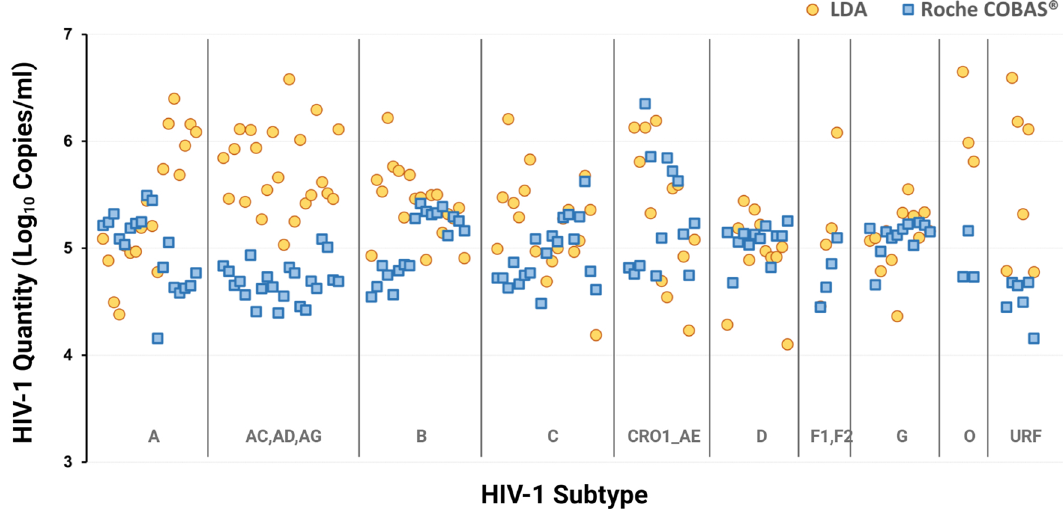
Figure 3. Comparison of HIV-1 viral load measurements by HIV-1 subtype determined by the revised laboratory developed assay (LDA) and the Roche Cobas AmpliPrep/Cobas TaqMan HIV-1 test v2.0